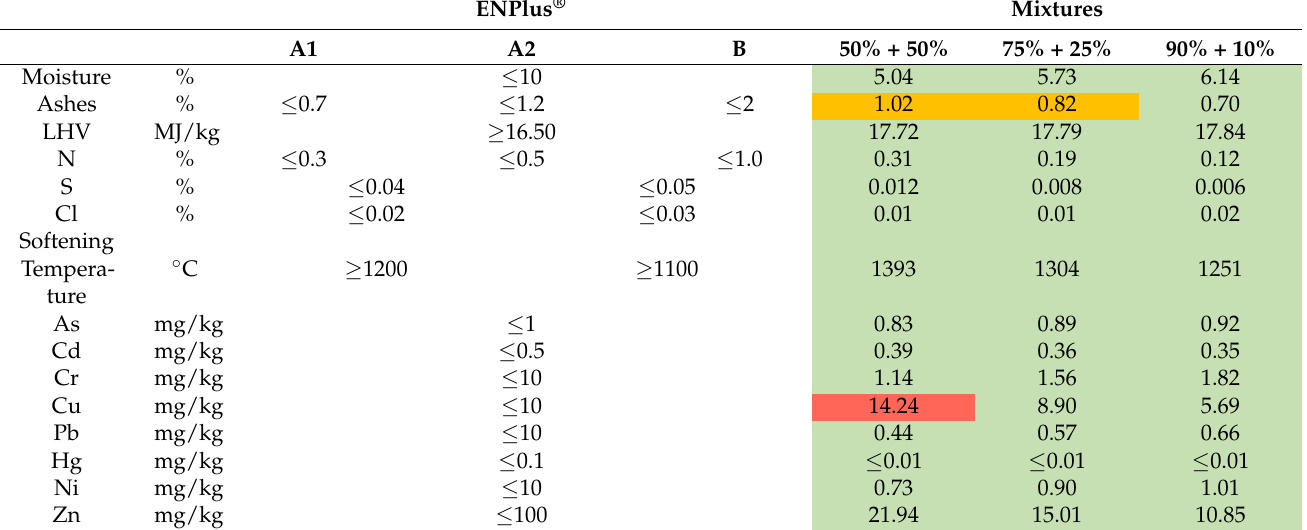
Table 14. Mixtures of Pinus pinaster wood and vine pruning (PP% + VP%). ENPlus ®